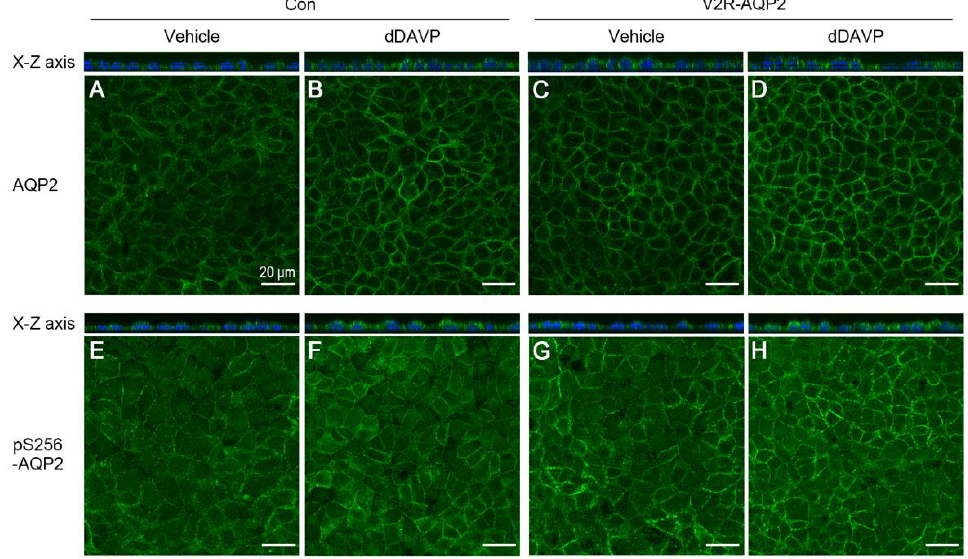
Figure 4. Immunofluorescence of total AQP2 and pS256-AQP2 in control mpkCCDc14 cells and V2R-AQP2 cells. Immunofluorescence staining of total AQP2 ( A – D ) and pS256-AQP2 ( E – H ) in